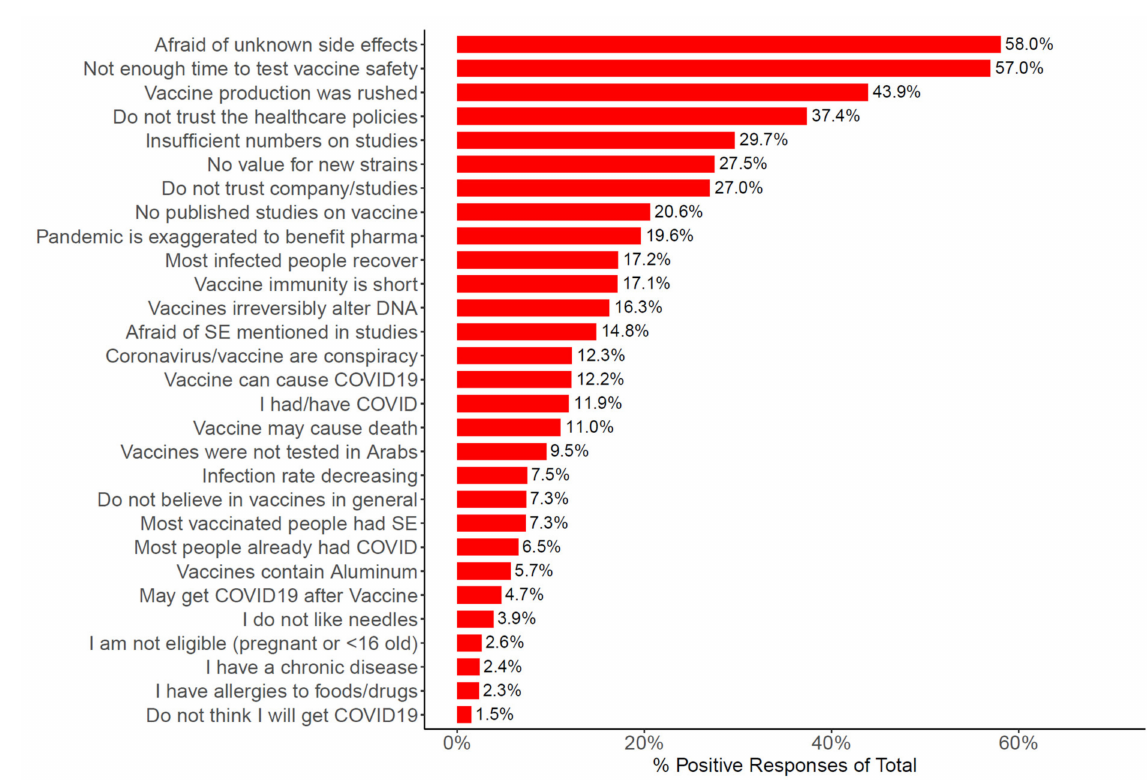
Figure 4. Bar plot showing percentage of participants ( n = 5708) who selected the shown barriers.